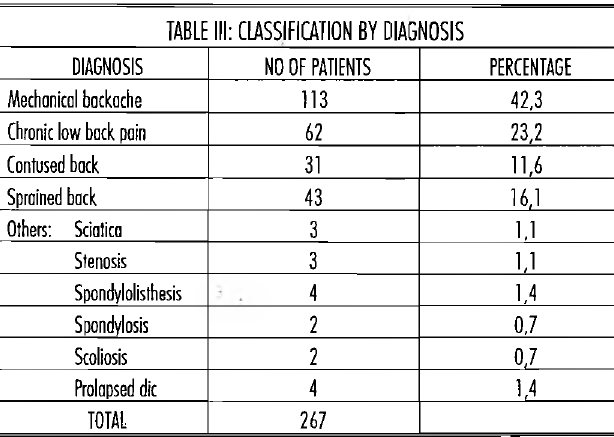
TABLE III: CLASSIFICATION BY